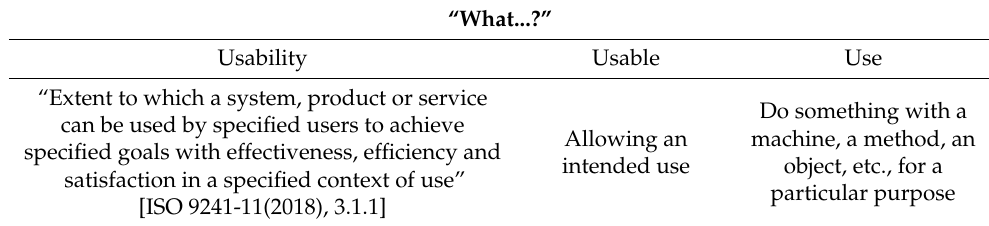
Table 3. Definition of the term usability.